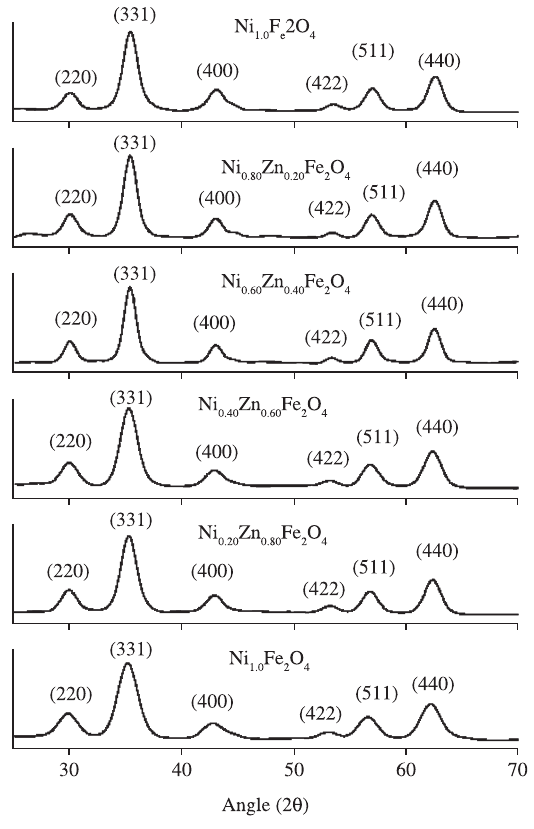
Figure 1. Indexed X-ray diffraction pattern for Ni 0.4, 0.6, 0.8 and